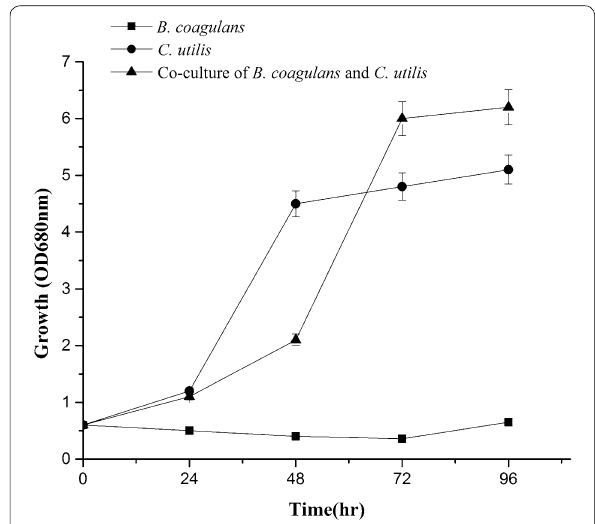
Fig. 2 Growths of B. coagulans and C. utilis in single and co-culture using LFW as